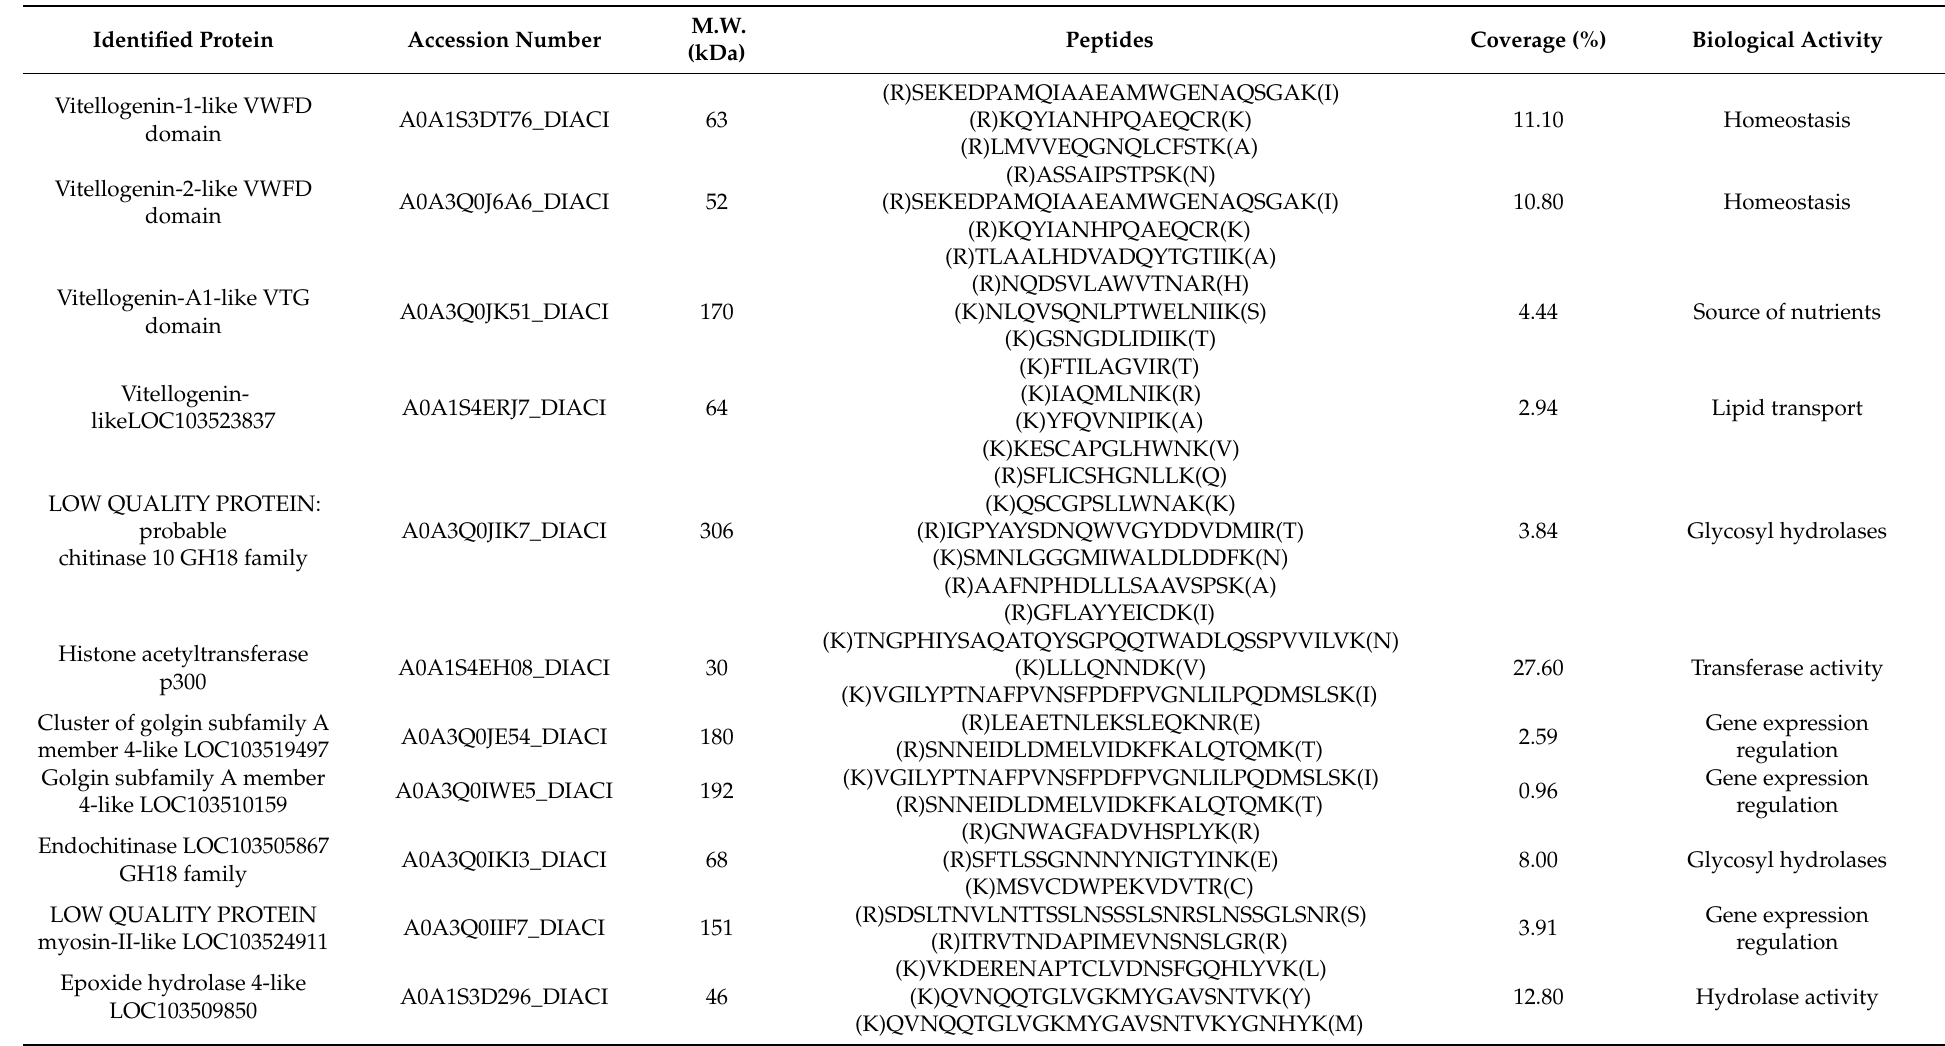
Table 1. Proteins identified from Diaphorina citri